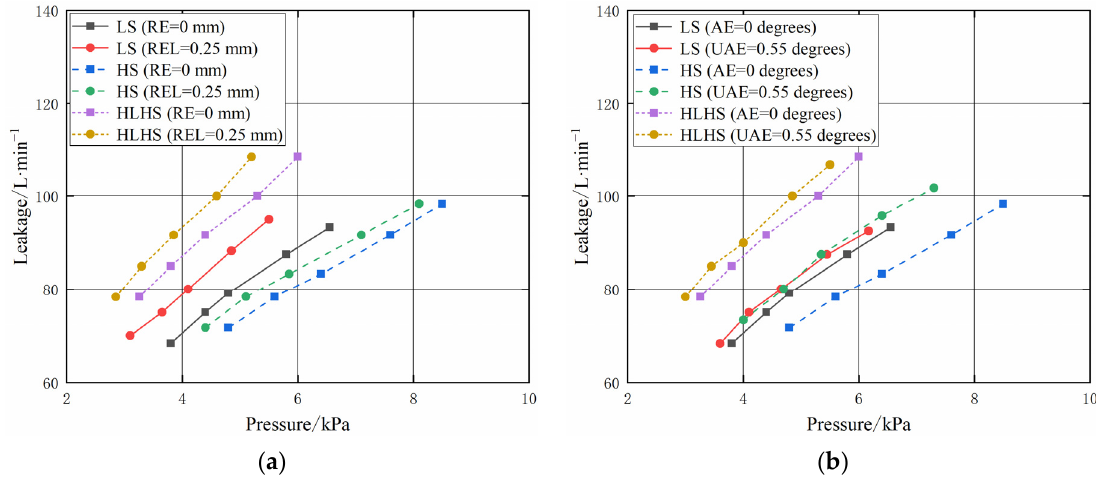
Figure 19. Leakage of three types of seals under different eccentricities. ( a ) Radial eccentricity; ( b ) angular eccentricity.